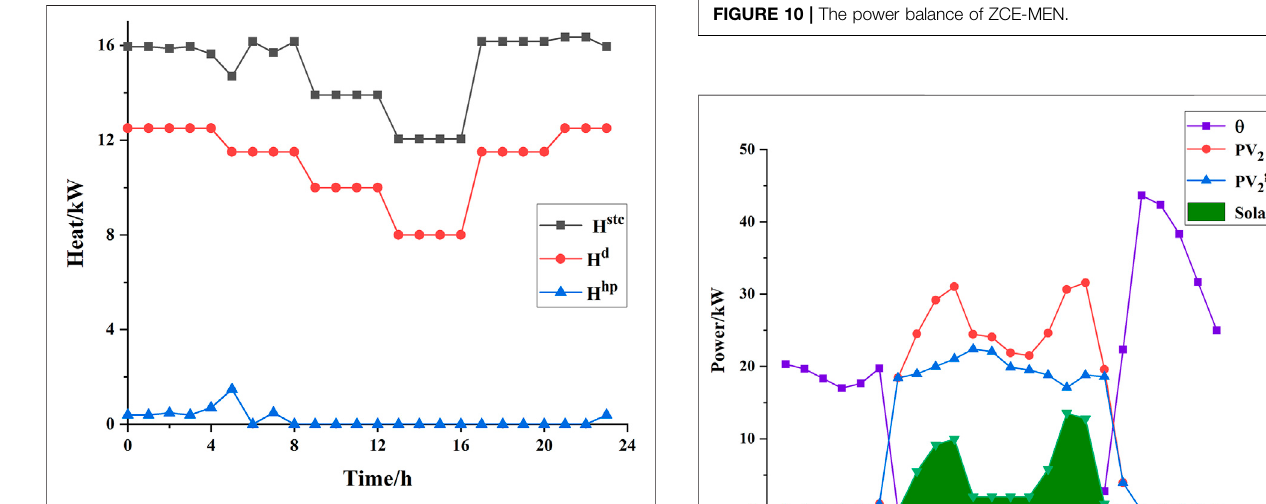
FIGURE 9 | Heat output of STC module, HA-CAES, and heat pump.